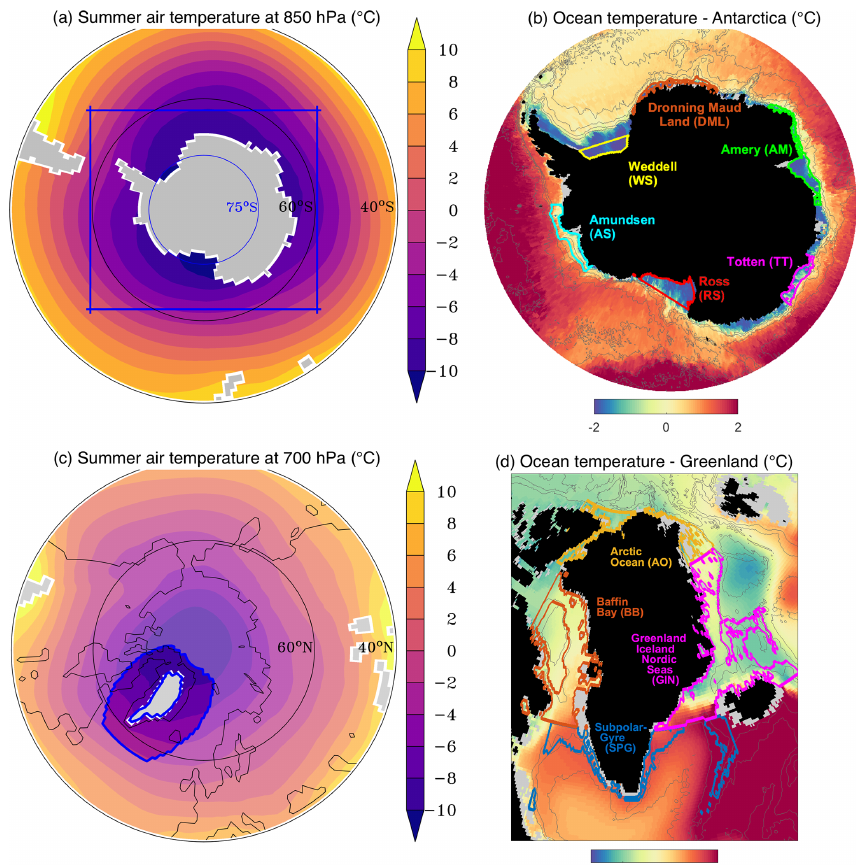
Figure 1. Atmosphere and ocean regions defined for metric computation. (a) For Antarctic atmosphere and surface ocean metrics, we considered the domain south of 40 ◦ S over ocean (color shading). The blue box shows standard lateral boundaries for regional climate models. Color shading is ERA-Interim summer air temperature at 850hPa over 1980–2004. (b) For Antarctic ocean metrics, we considered six ocean sectors shallower than 1500m. Color shading shows the depth-integrated temperature of our reference historical climatology. (c) For Greenland atmosphere metrics, we considered the domain inside the usual boundaries of MAR simulations in that region, i.e., inside the blue box, except where ice sheet topography is above 2000ma.s.l. (bright color shading). Color shading is ERA-Interim summer air temperature at 700hPa over 1980–2004. (d) For Greenland ocean metrics, we considered the four sectors shown with different colored outlines. Color shading shows the depth-integrated (200 to 500m) temperature of our reference historical